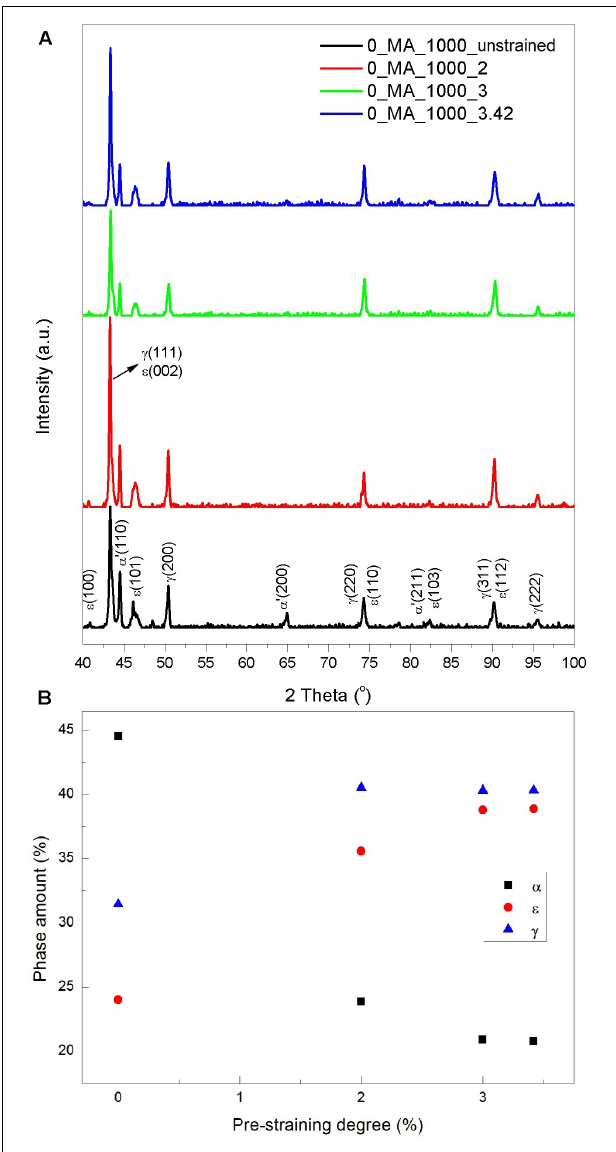
FIGURE 9 | Effects of pre-straining degree increase at 0_MA_1000 specimens: (A) XRD patterns and (B) phase amounts of α (cid:48) -bcc martensite, ε -hcp martensite and γ -fcc austenite (reproduced after Pricop et al., 2018, with permission granted by Taylor &